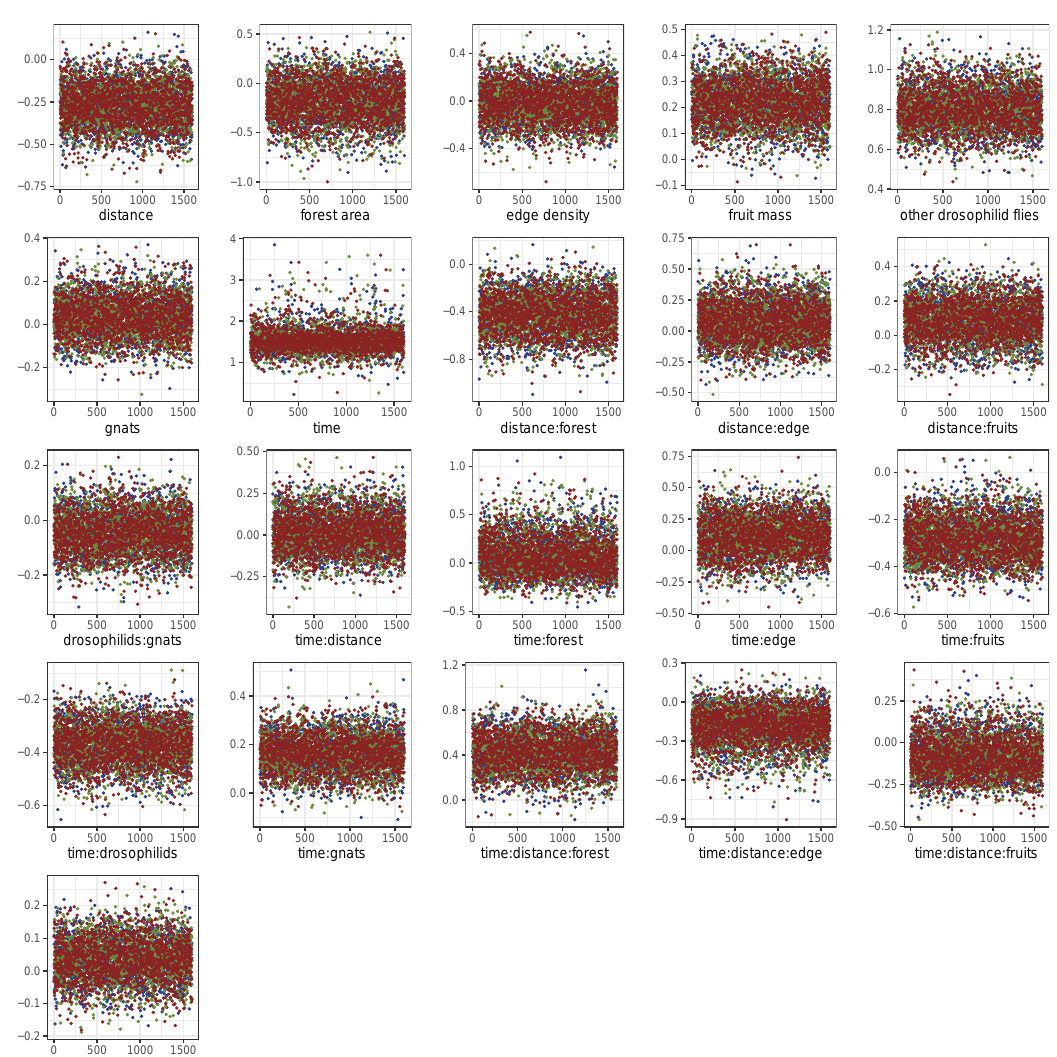
Figure A5. Traceplot showing parameter values (points) chosen by the three chains (colors). Please note that the variable time is represented by calendar weeks and burnins are